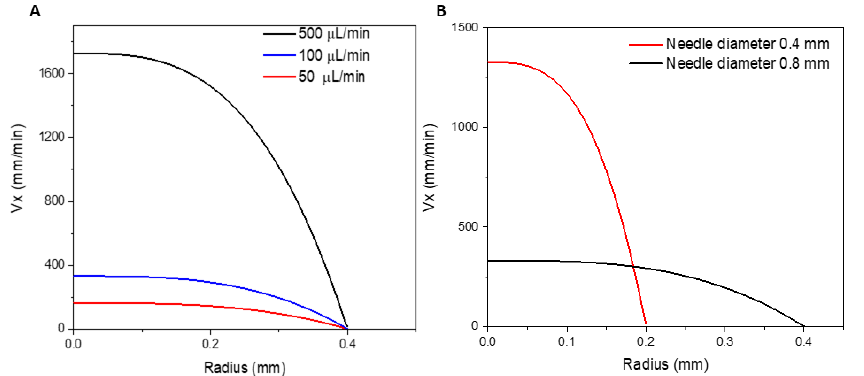
Figure 9. Variation of Vx profile at the outlet for different velocities with respect to radius evaluated at ( A ) different flow rates and at ( B ) different needle diameters and fixed flow rate of 100 µL/min. Vx is the horizontal x component of the flow velocity. The x -axis is parallel to the symmetry axis of the needle.